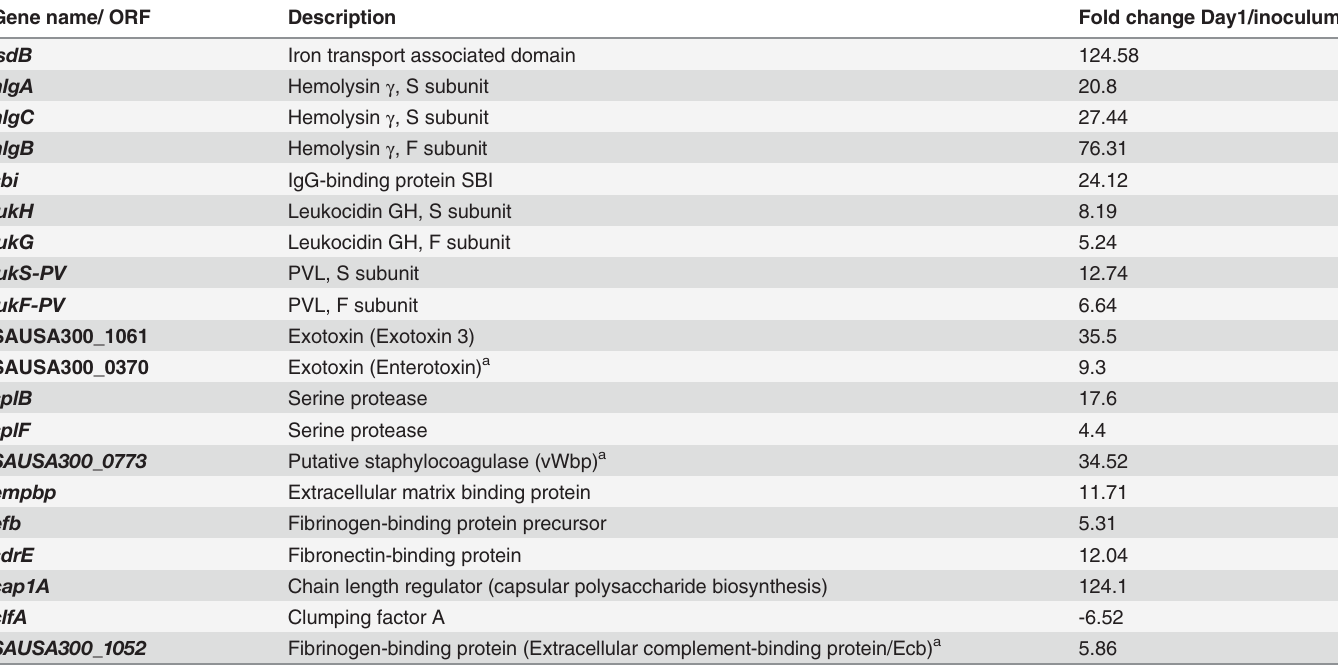
Table 1. Changes in USA300 transcript levels of selected virulence factor-encoding genes in rabbit skin abscesses at 24 h post infection.